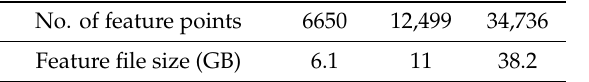
Table 1. The relationship between the number of feature points and the size of the feature file.